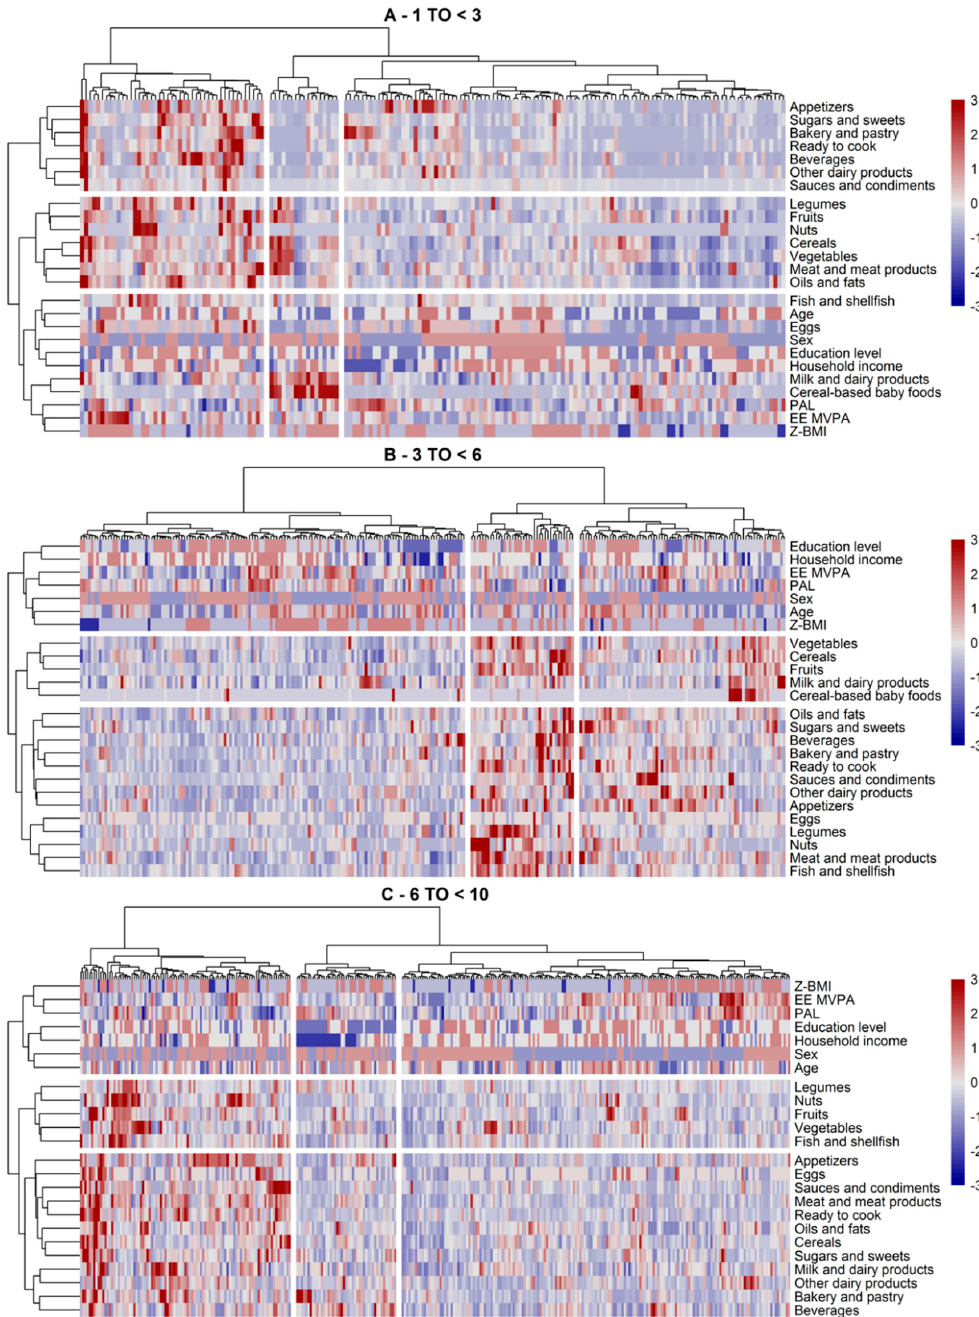
Figure 3. Clusters of subjects and dietary and lifestyle variables identified via hierarchical clustering in SRS by age groups (( A ) 1–3 years, ( B ) 3–6 years, ( C ) 6 to < 10 years) in the Nutritional Study in Spanish Pediatric Population (EsNuPI) ( n = 740). The clusters are visually separated by longitudinal marks on vertical and horizontal faces (clusters of subjects or dietary / lifestyle variables, respectively). The vertical and horizontal dendrograms denote the relationship between the clusters, i.e., similar observations. The color bar refers to levels above (red) or below (blue) the mean intake of the dietary variable or mean scores of lifestyle variables. Increased color intensities indicate larger differences around the mean. Abbreviations: EE MVPA, energy expenditure moderate and vigorous physical activity; PAL, physical activity level; Z-BMI-for-age, body mass index for age z-score.